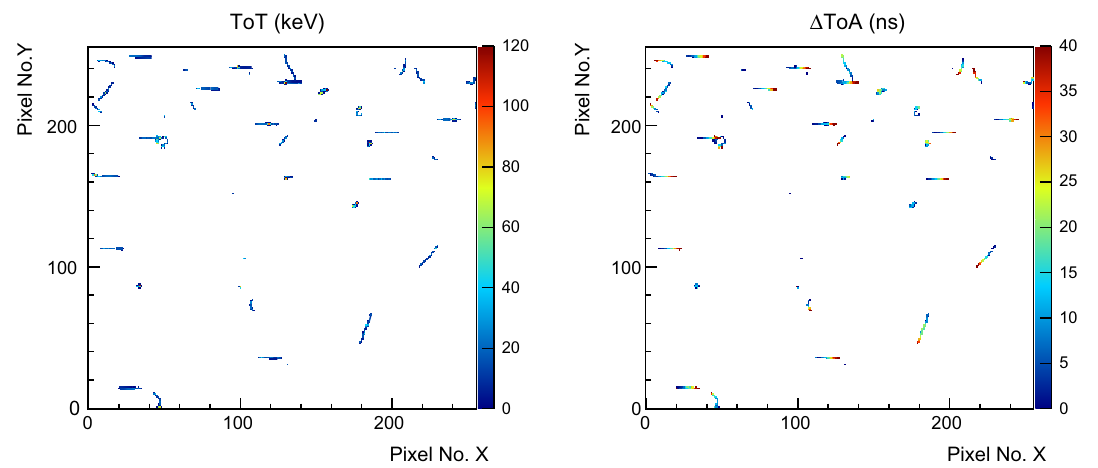
Fig. 5 A set of 50 tracks from the measurement in a 120GeV/c pion beam. The Timepix3 measures the energy deposit in every pixel ( left ) and the time of the interaction ( right ). The bias voltage was 130V